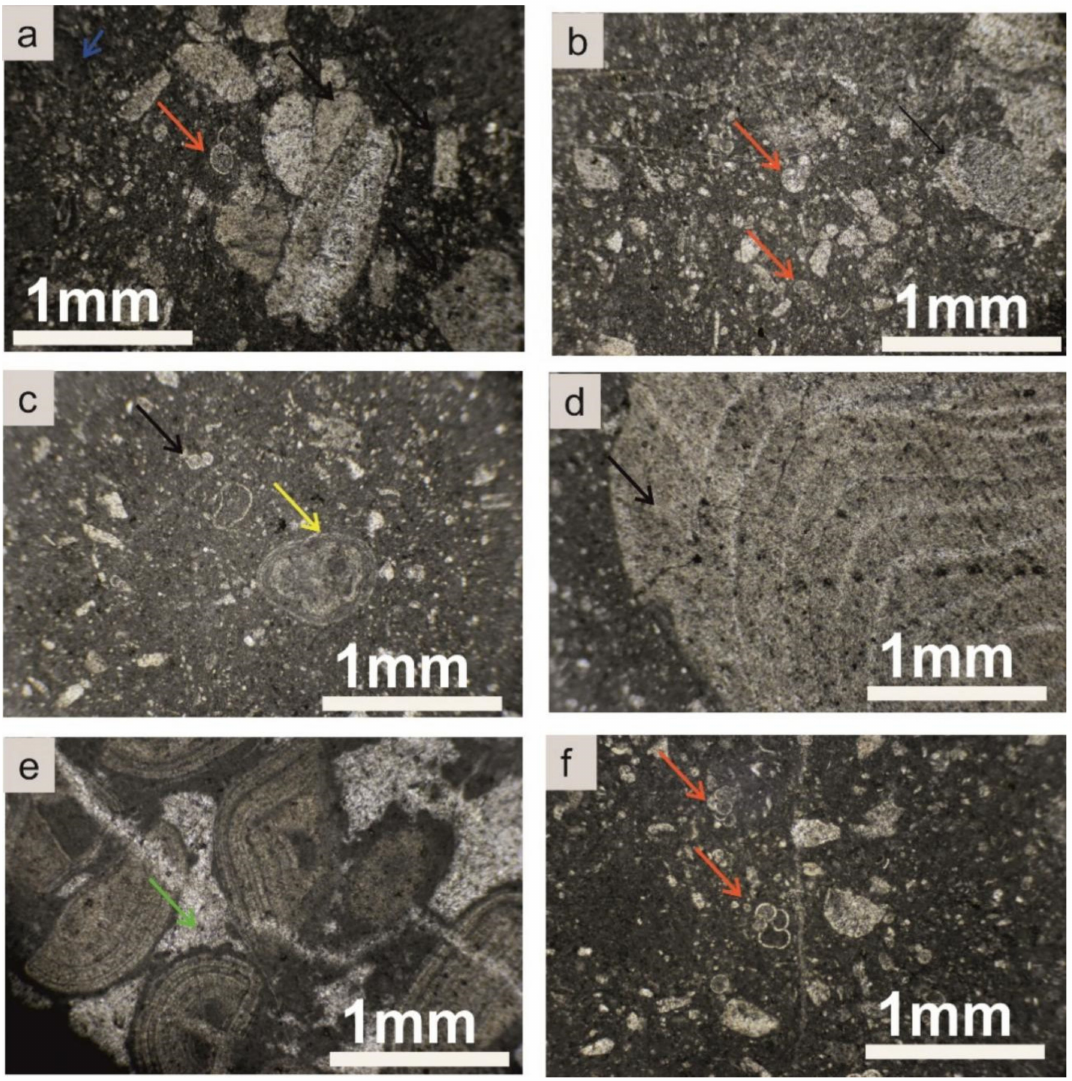
Figure 6. Representive photomicrographs of F1 microfacies type -: Allochthonous, bioclastic- lithoclastic packstone/floatstone microbreccia of Maastrichtian age. ( a ) planktic foraminifera (red arrow), micritic clast (purple arrow), bioclasts (black arrow), sample K17, ( b ) planktic foraminifera (red arrow), bioclasts (black arrow), sample K17, ( c ), bioclasts (recrystallized planktic foraminifera, black arrow), pisoids (yellow arrow), sample K1, ( d ) bioclasts (rudist? black arrow), sample K1, ( e ) ooids (green arrow), ( f ) planktic foraminifera (red arrow), sample